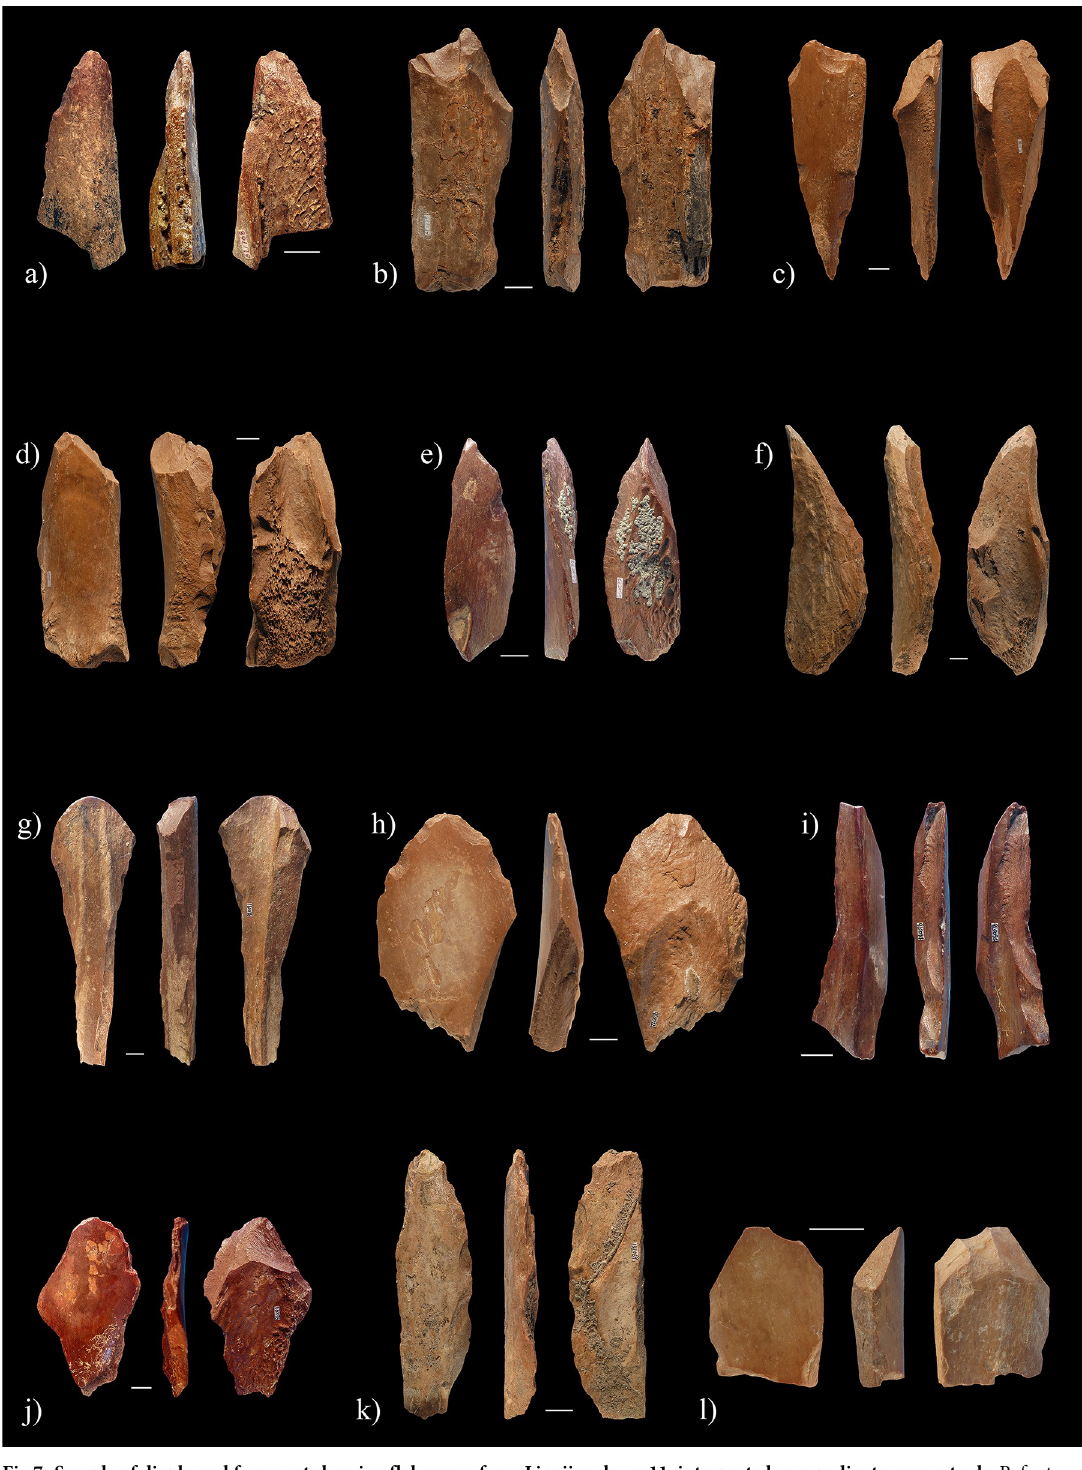
Fig 7. Sample of diaphyseal fragments bearing flake scars from Lingjing, layer 11, interpreted as expedient osseous tools. Refer to S1 Table for data. Scales = 1cm.